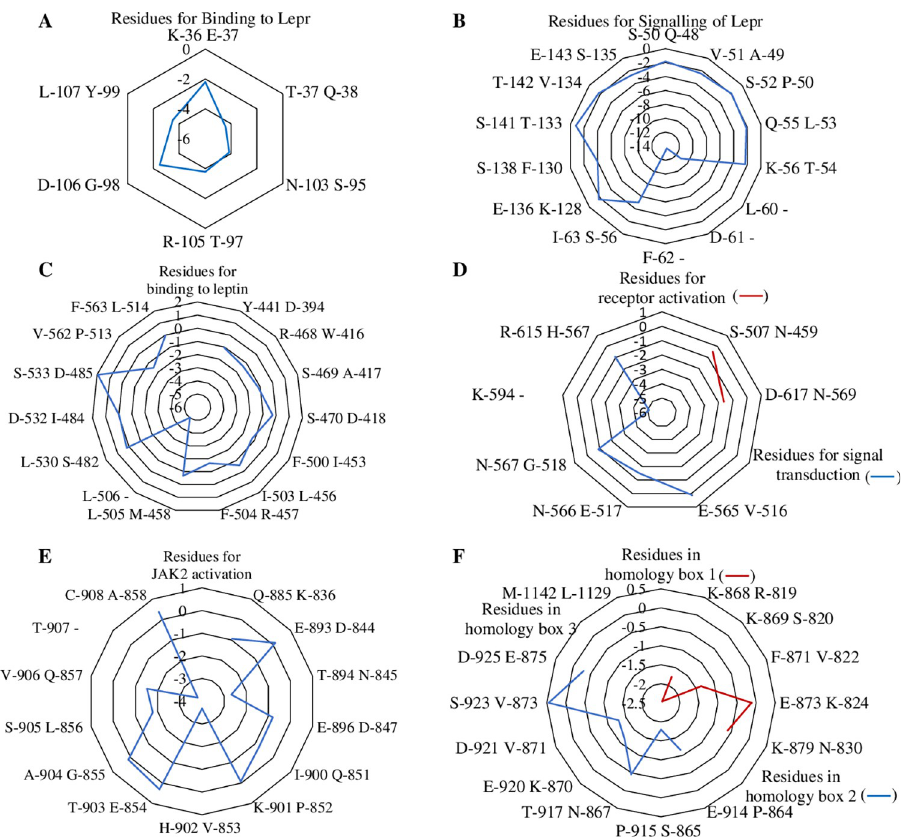
Fig 2. Polar curves showing PROVEAN score of the amino acids exhibiting substitution/deletion at the significant sites of (A,B) leptin and (C-F) leptin receptor. The position of amino acid increases clockwise and effect of substitutions/deletions at functionally important sites is identified at a threshold score of -2.5 considering human LEP and LEPR as reference. The PROVEAN score � -2.5 implies that the protein variant would have “deleterious” effect while a score > -2.5 predicts that the variant would have a “neutral” effect.